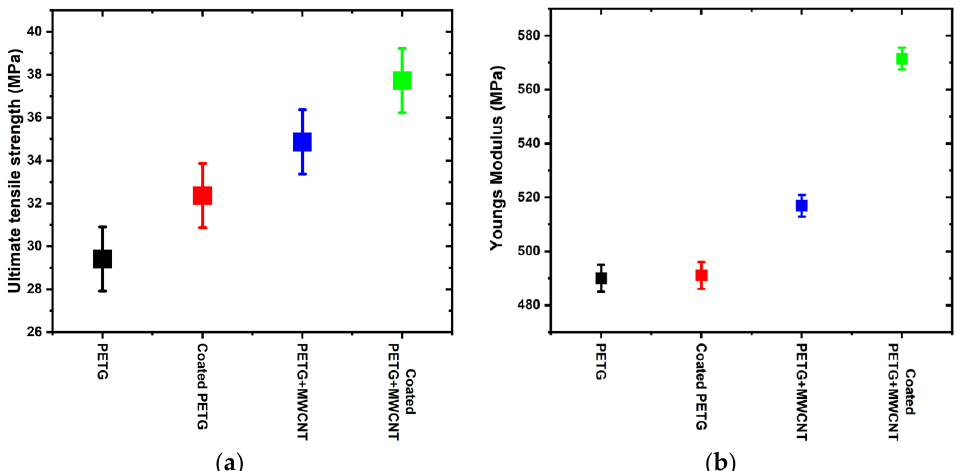
Figure 8. ( a ) Ultimate tensile strength of various tensile samples; ( b ) Young’s modulus of PETG specimens.